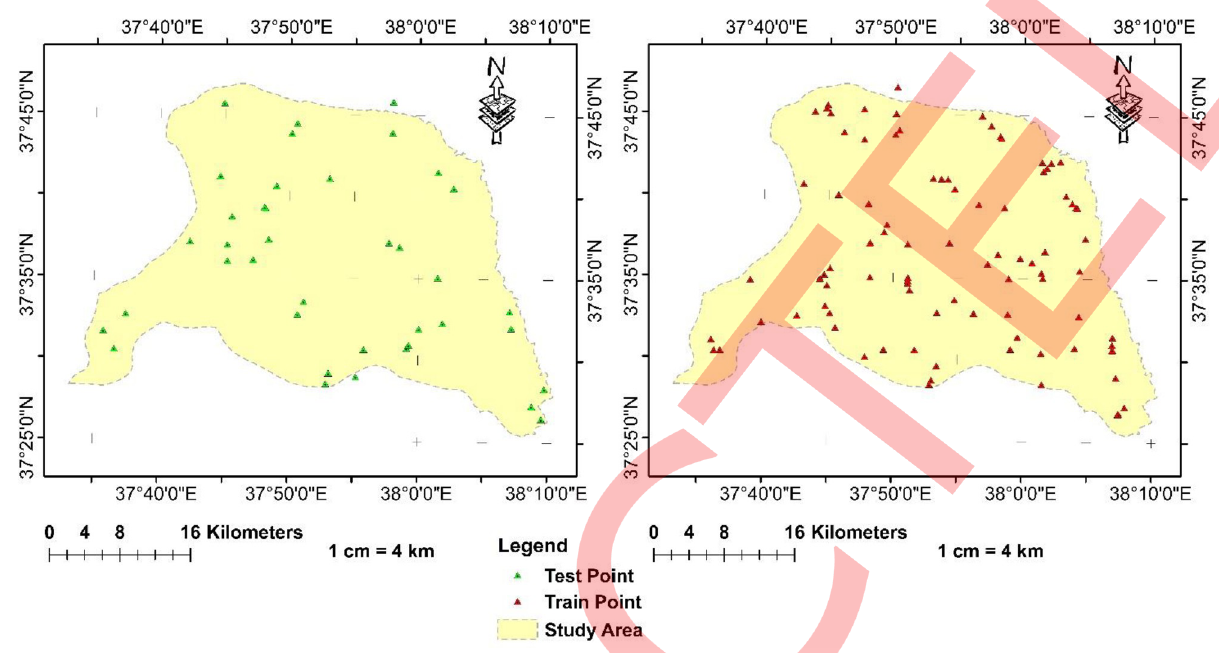
Fig 1. Geographical location of the study area and spatial distribution of the train and test dataset used for the model.